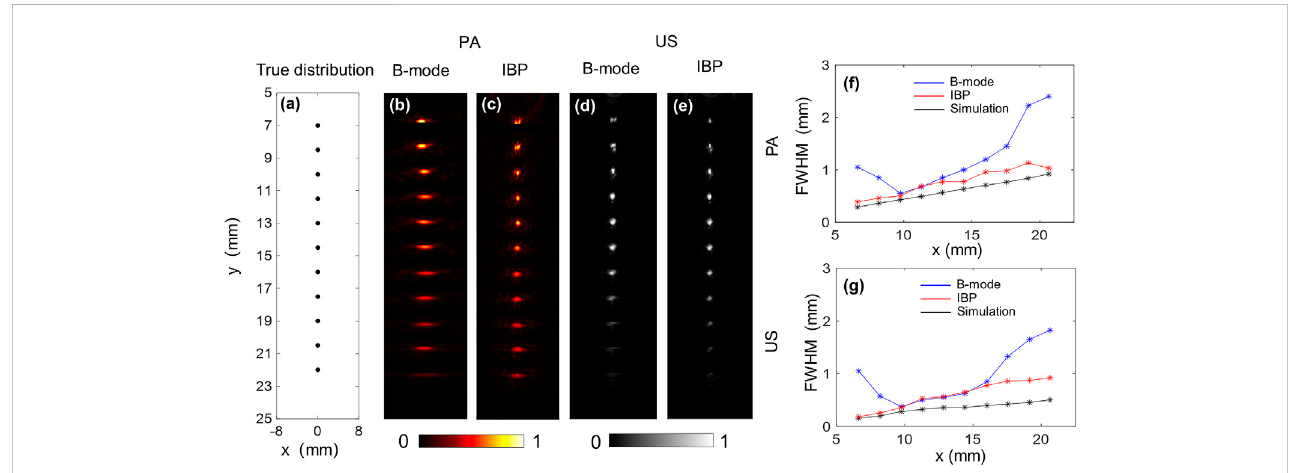
FIGURE 2 Field test results show lateral resolution changes at different depths of the proposed system, acquired with a point target. (A) The true distribution of the point targets; (B) and (C) are the photoacoustic images of the point target by the B-mode and IBP methods, respectively; (F) Obtained FWHMs at different depths from (B) and (C) . The blue and red lines were calculated from (B) and (C) , and the black line is the simulation results; (D) , (E) , and (G) are the corresponding results for ultrasound imaging. The maximum amplitudes of the PA and US images are normalized for facilitated comparison.